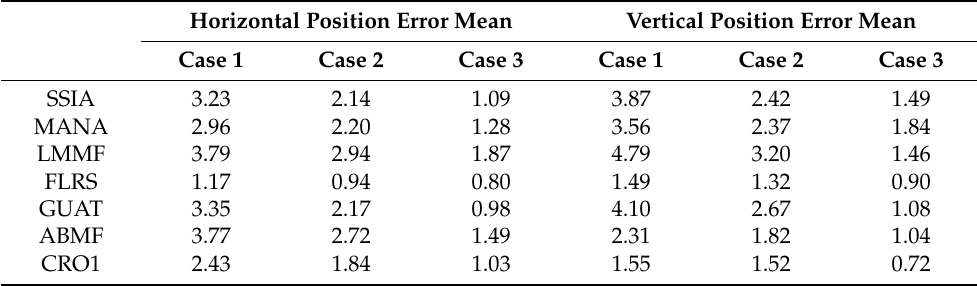
Table 4. One month STD of horizontal and vertical positioning errors in March 2015.